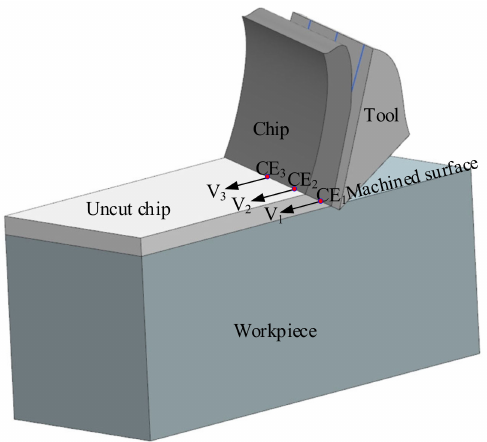
Figure 3. Diagram of velocity directions in oblique